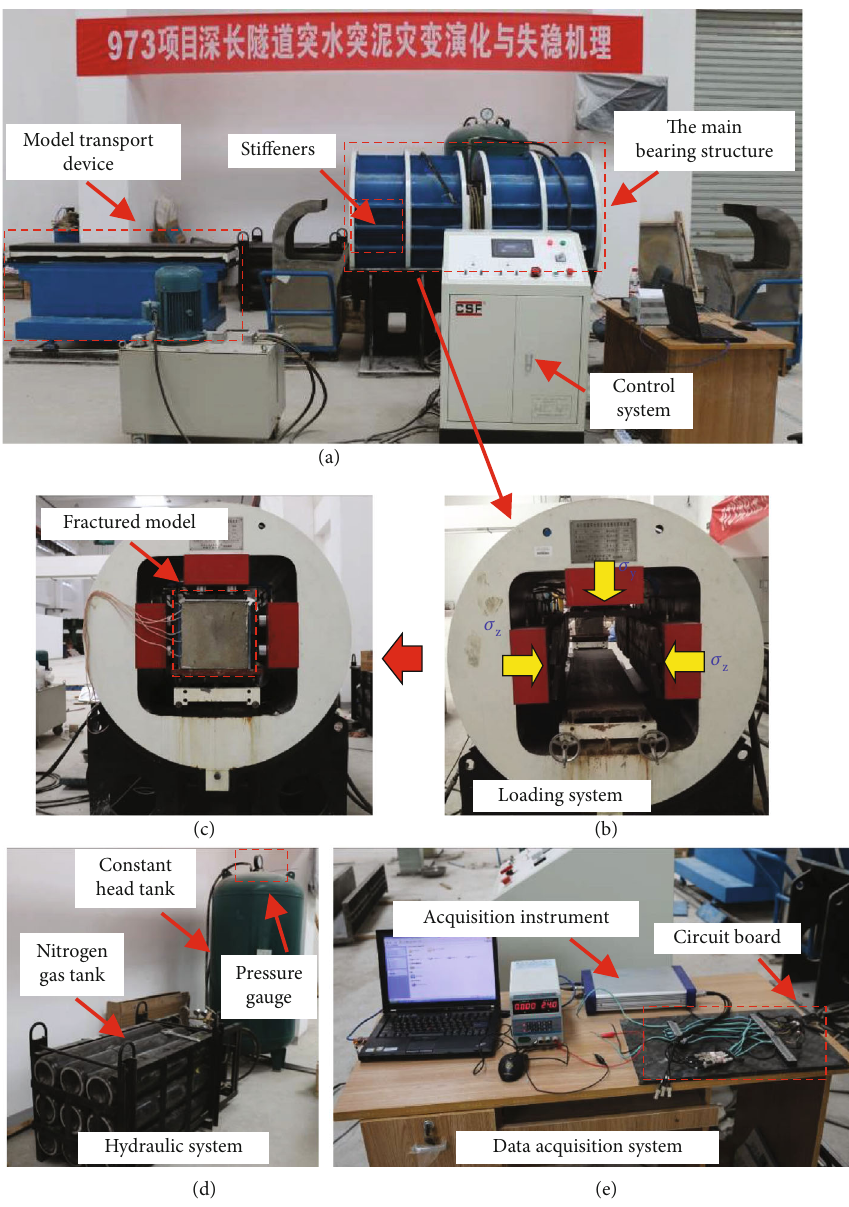
Figure 3: Large-scale three-dimensional fl uid fl ow testing